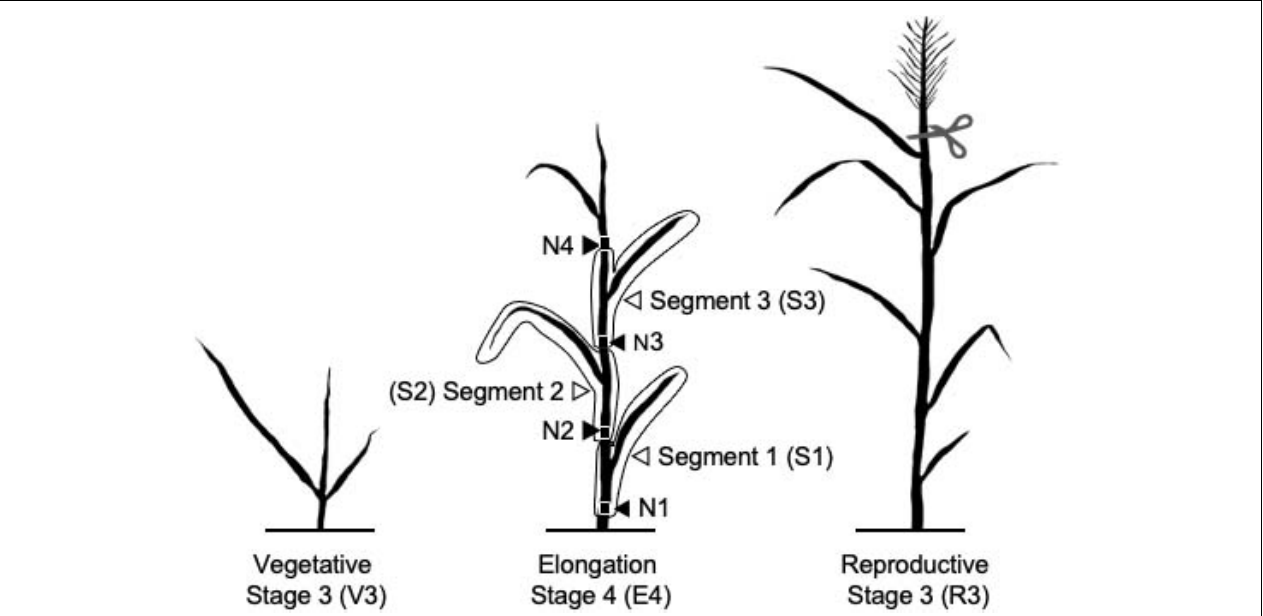
FIGURE 1 | Diagram of switchgrass stages and segments characterized in this experiment. N indicates nodes. Panicle was removed from the R3